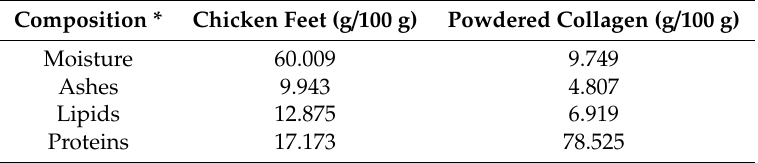
Table 6. Chemical composition of chicken feet and their powdered collagen.